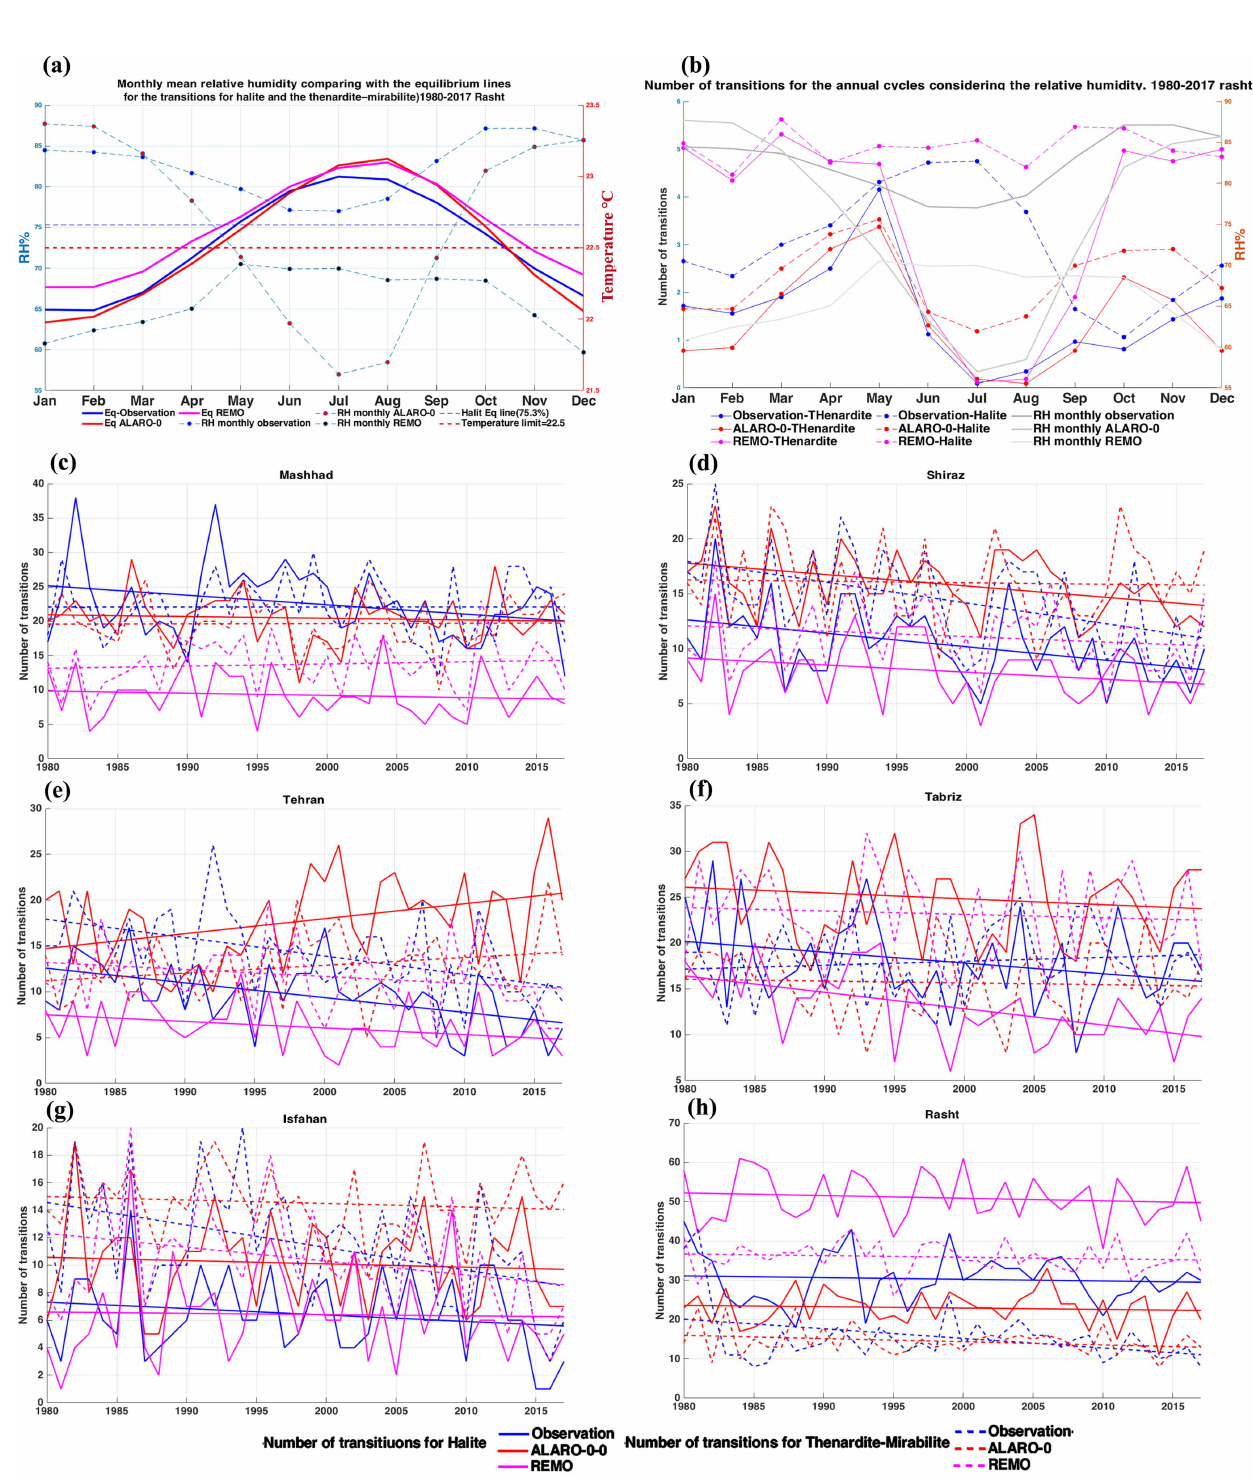
Figure 11. ( a ) Mean monthly relative humidity comparing with equilibrium lines of transitions of halite and thenardite– mirabilite for Rasht. ( b ) The number of transitions for annual cycles comparing ALARO-0 and REMO with observations considering relative humidity in Rasht. The yearly number of phase transitions for halite and thenardite–mirabilite comparing ALARO-0 and REMO with observations over the studied stations: Mashhad ( c ), Shiraz ( d ), Tehran ( e ), Tabriz ( f ), Isfahan ( g ) and Rasht ( h ) during